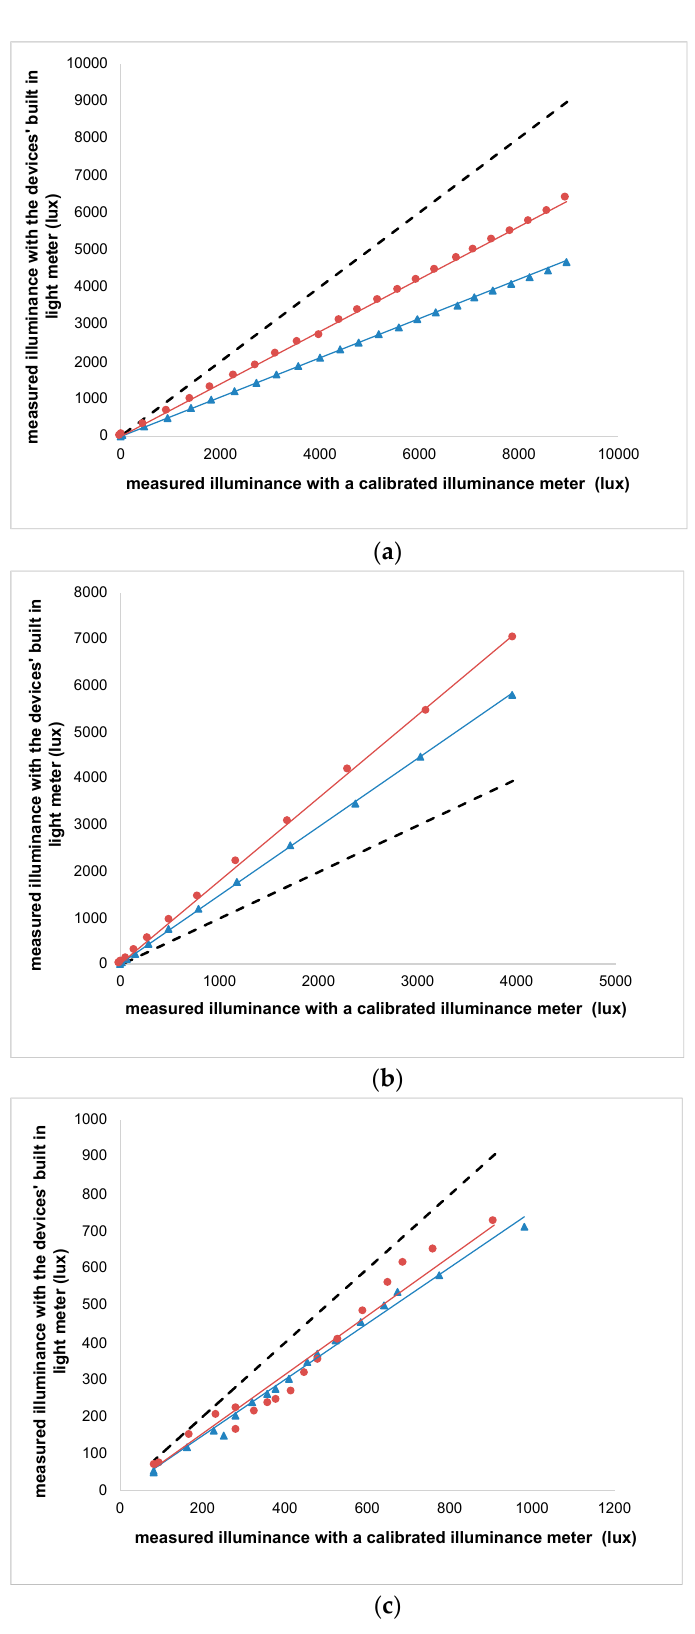
Figure 4. Comparison of illuminance measured by Galaxy Tab S2 tablet (red circles) and the Samsung S6 + Smartphone (blue triangles) ambient light sensors to those measured with calibrated illuminance meter (Konica Minolta Sensing T-10A). ( a ) Wide angle homogeneous source; ( b ) Small angular source; ( c ) Office environment. The dashed black line represents the line Y = X.